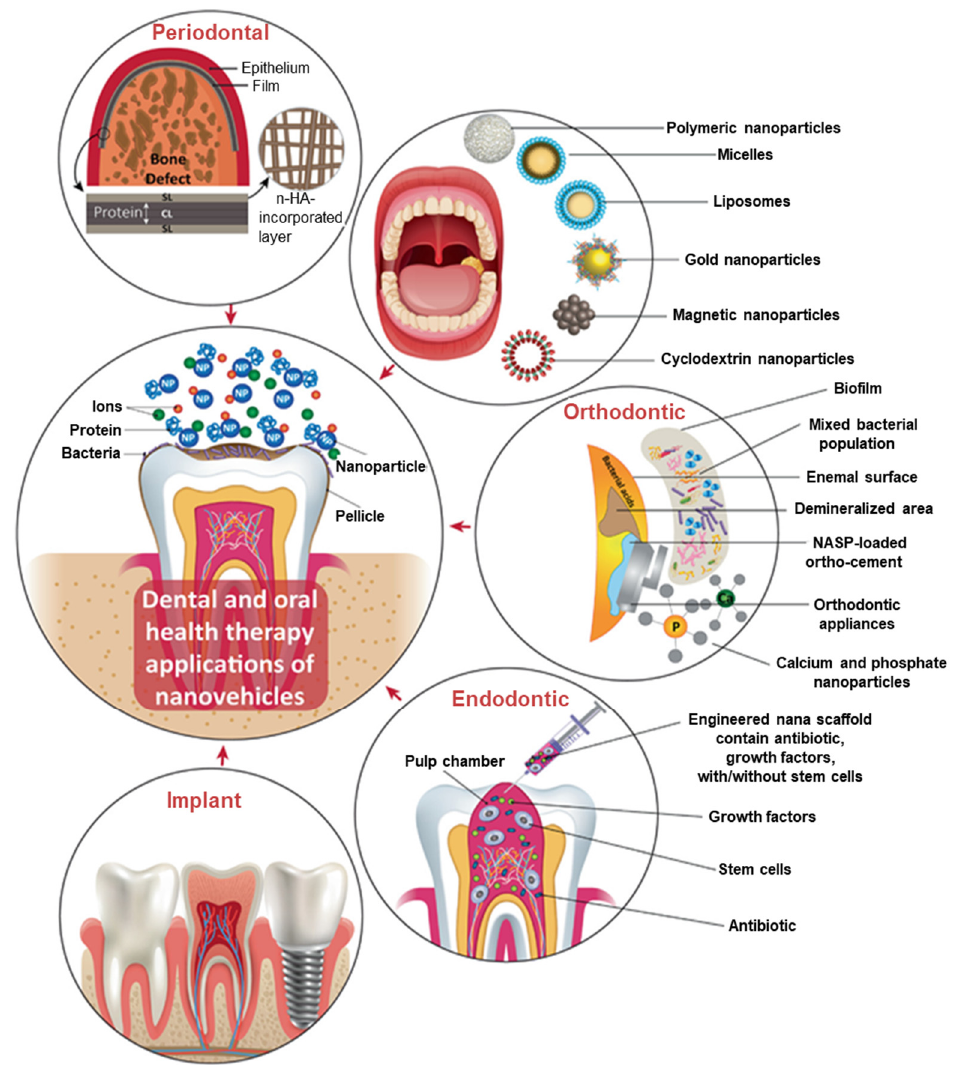
Figure 1. Applications of organic and inorganic nanomaterials in dental care and treatment. Abbreviations: HA: hydroxyapatite, NASP: nano-sized amorphous calcium phosphate. Reprinted with permission from Ref. [76], 2021, Wiley.